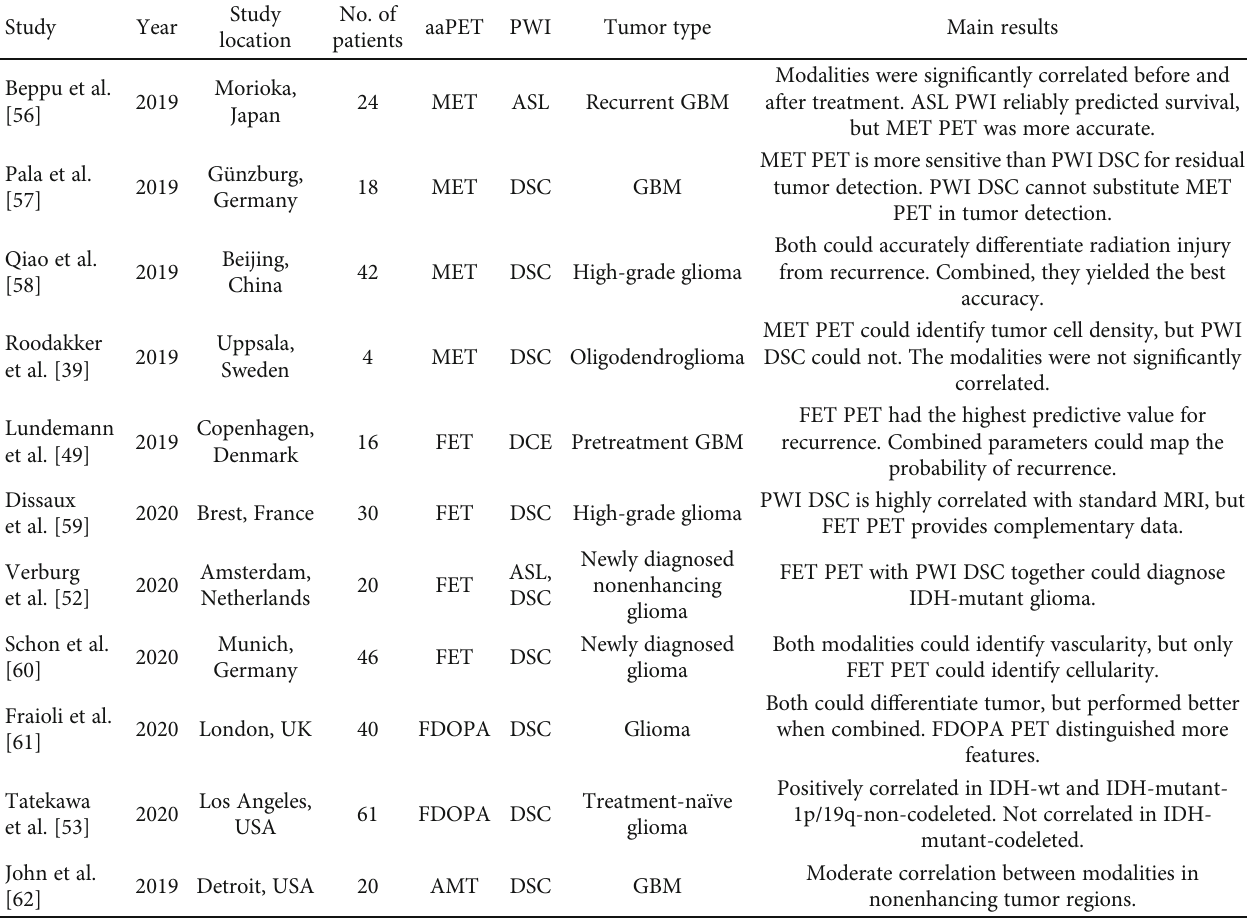
Table 2: Summary of aaPET with PWI studies.